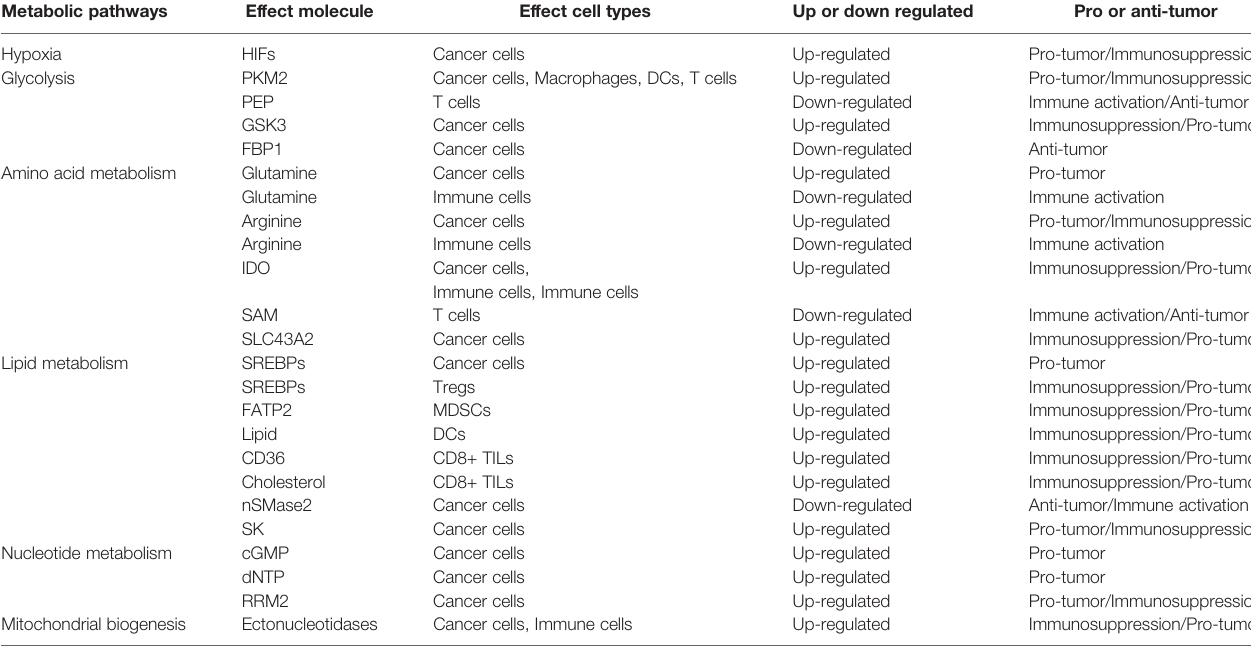
TABLE 2 | The effect of key metabolic targets on cancer cells and immune cells in the TME. Metabolic